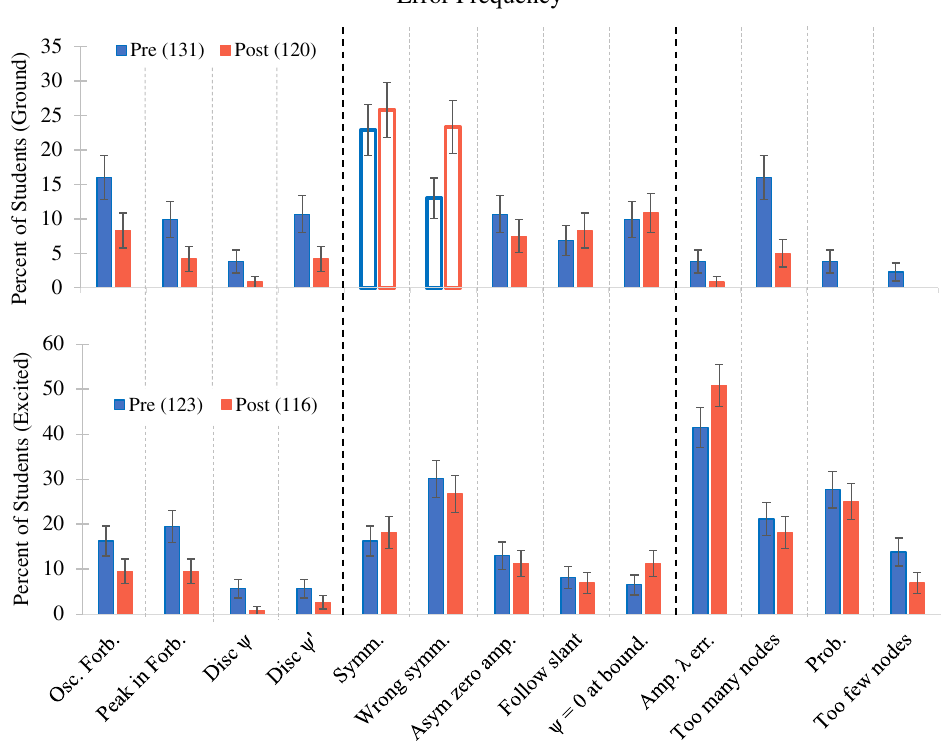
FIG. 3. Pre- and postcomparison of student errors on the drawing of ground state wave functions and 2nd excited state wave functions. In general, errors are not mutually exclusive. The bars for the categories “ Sym. ” and “ Wrong sym. ” are not shaded in for the ground state, indicating that they were not considered in the grading of student responses for the ground state. Error bars represent binomial error, treating each student ’ s answer as a separate Bernoulli trial, and treating pretest groups and posttest groups entirely separately. The data correspond to all pretest data and all posttest data, not restructured to within-student paired pretests and